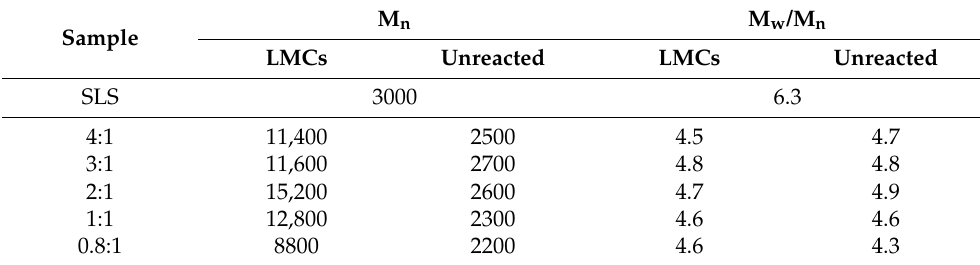
Table 1. The number average molecular weight distribution (M n ) and polydispersity index (PDI) of capsule-forming and unreacted SLS.